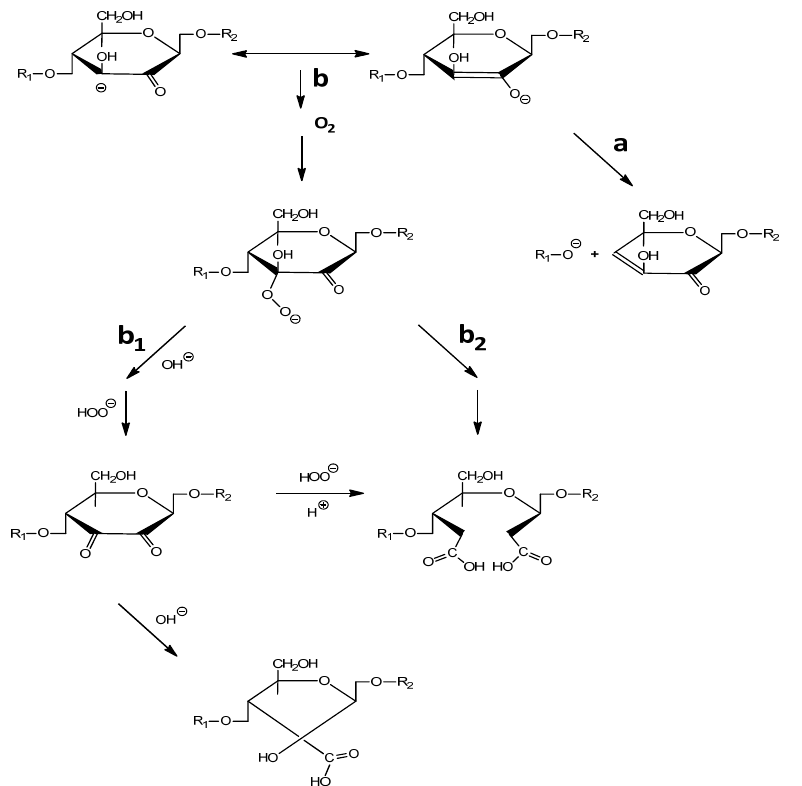
Figure 2. Oxidation of the cellulose chain and its products under O 2 -alkali.